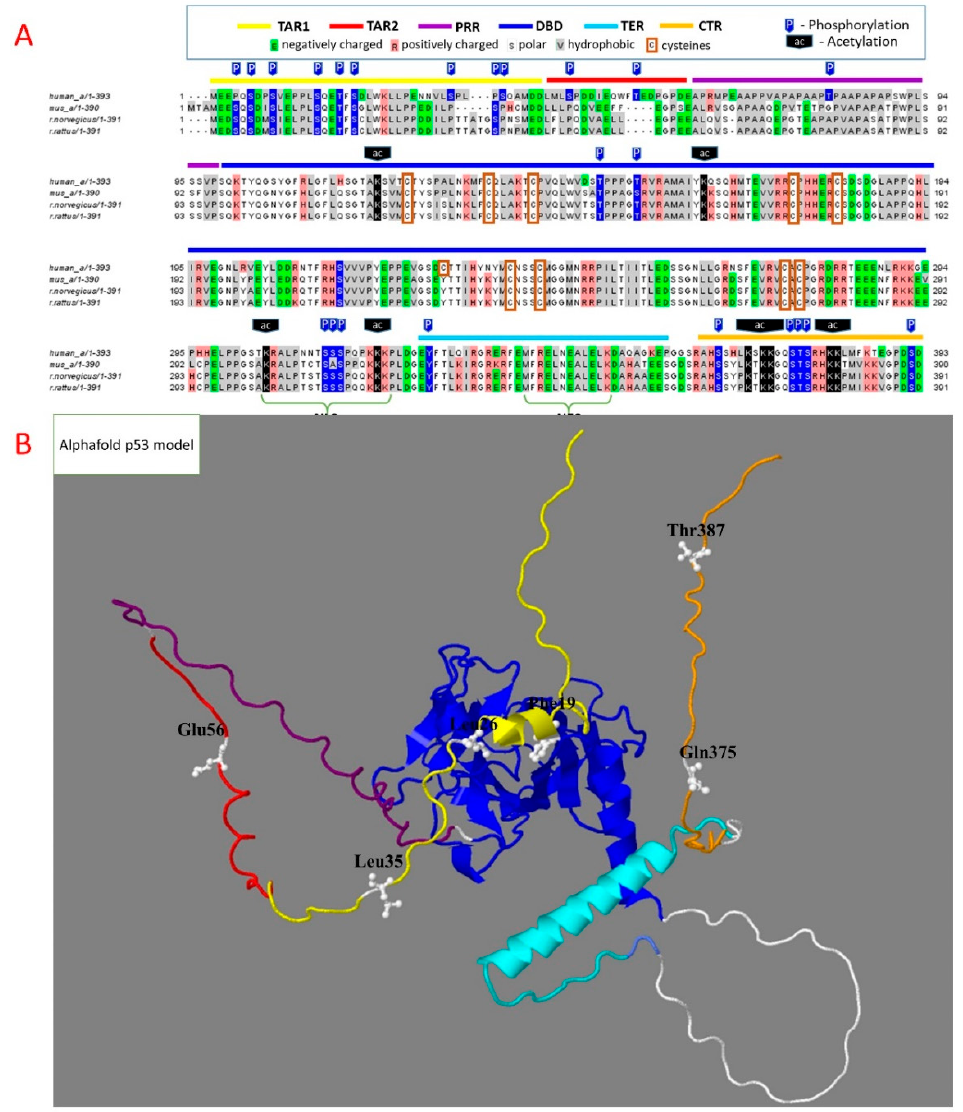
Figure 1. Structural determinants of p53 homo- and heterologous protein complexes. Throughout this and other figures, specific regions are highlighted by color: yellow—transactivation region 1 (TAR1), red—transactivation region 2 (TAR2), purple—proline-rich region (PRR), blue—DNA- binding domain (DBD), cyan—tetramerization region (TER), orange—C-terminal region (CTR). ( A )—Sequence of human p53 is aligned to that of model organisms, mouse and rat. Acetylation and phosphorylation sites with more than five references, according to the Phosphosite database, are marked as P (blue arrows) and Ac (black arrows) above the sequences. The cysteine residues are framed. ( B )—The 3D model of full-length p53 structure, predicted by AlphaFold (https://alphafold.ebi.ac.uk/entry/P04637, accessed on 6 January 2022). The marked residues define the regions acquiring secondary structure in heterologous protein complexes.